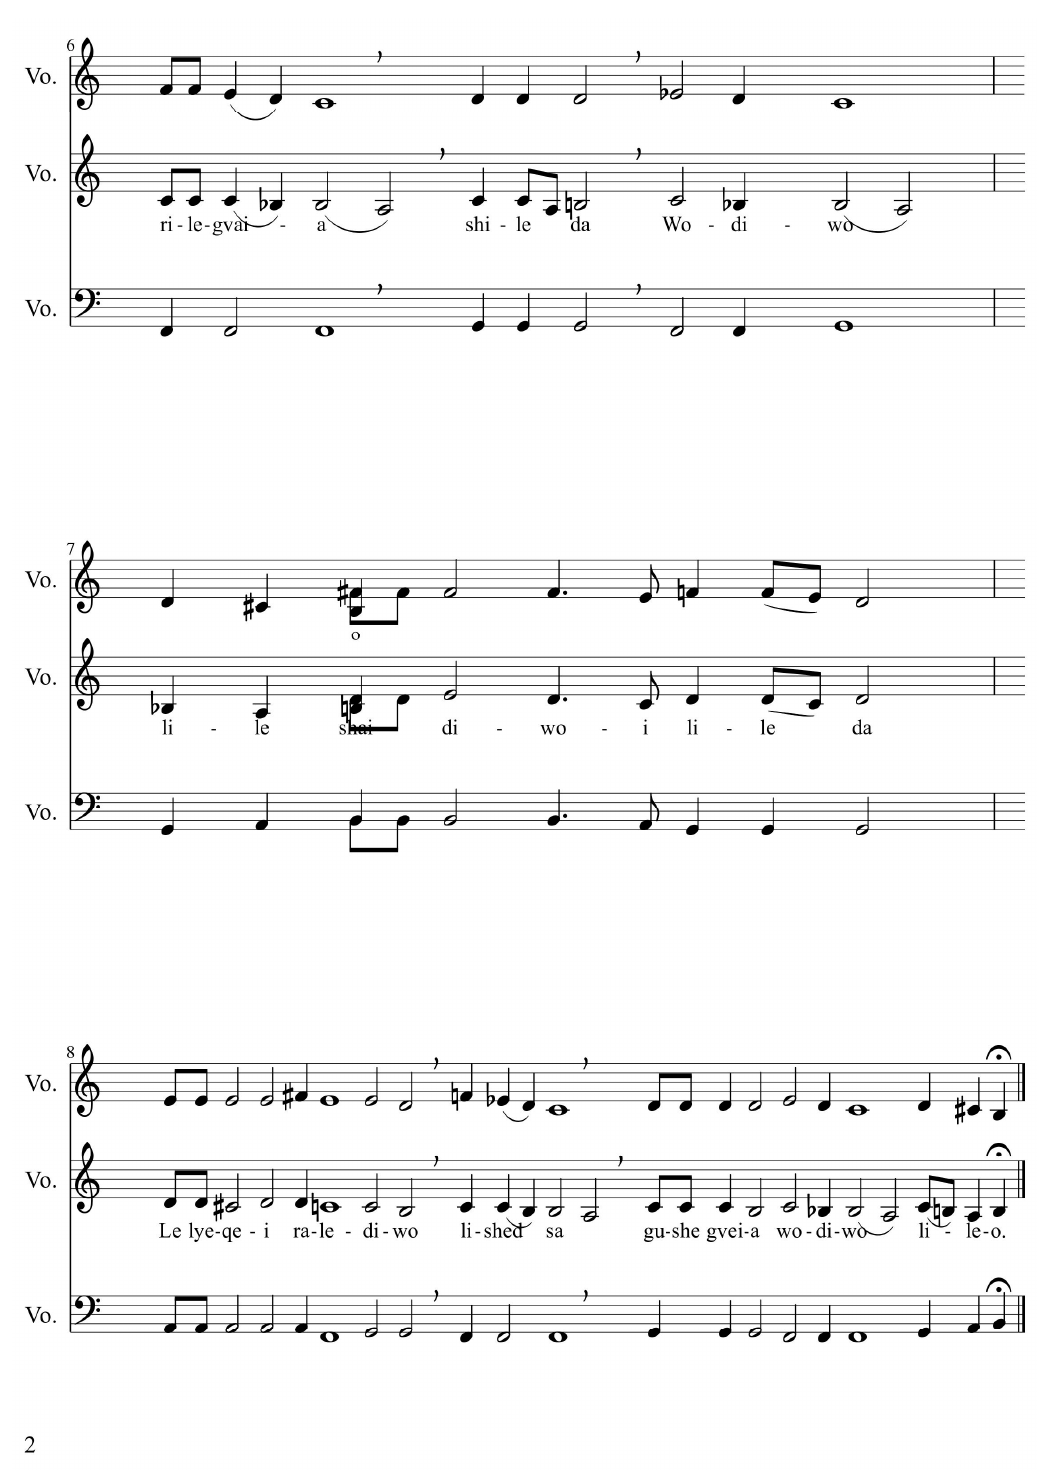
Figure 22. Lile; Svan hymn, Lakhushdi variant.